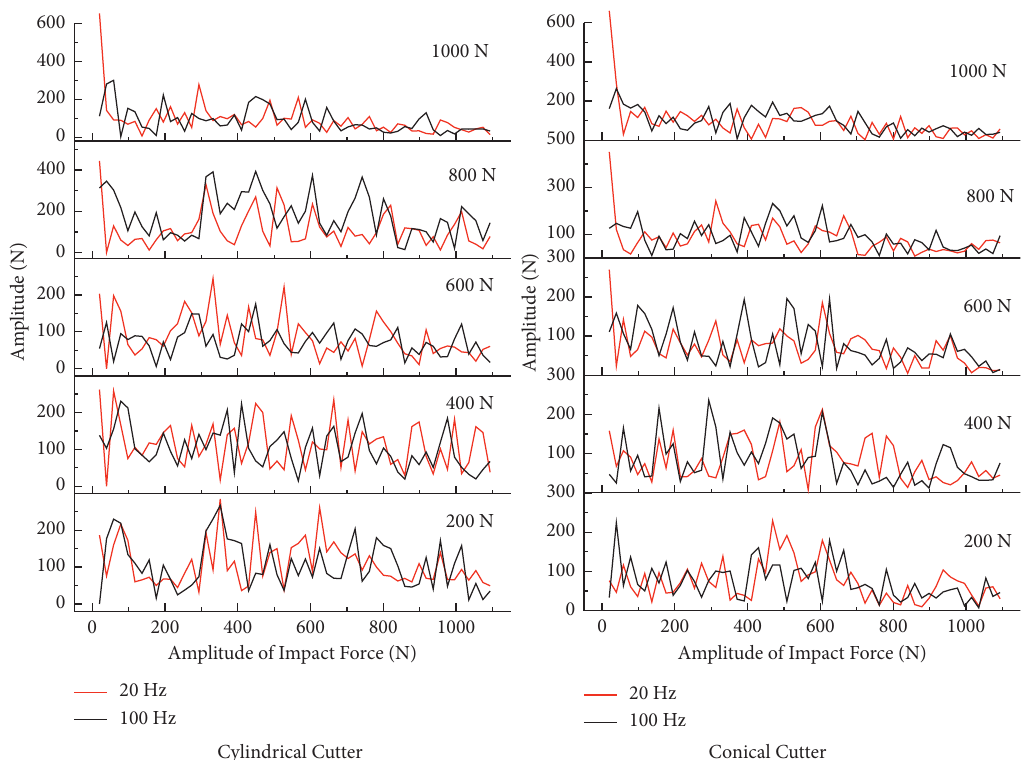
Figure 8: WOB frequency